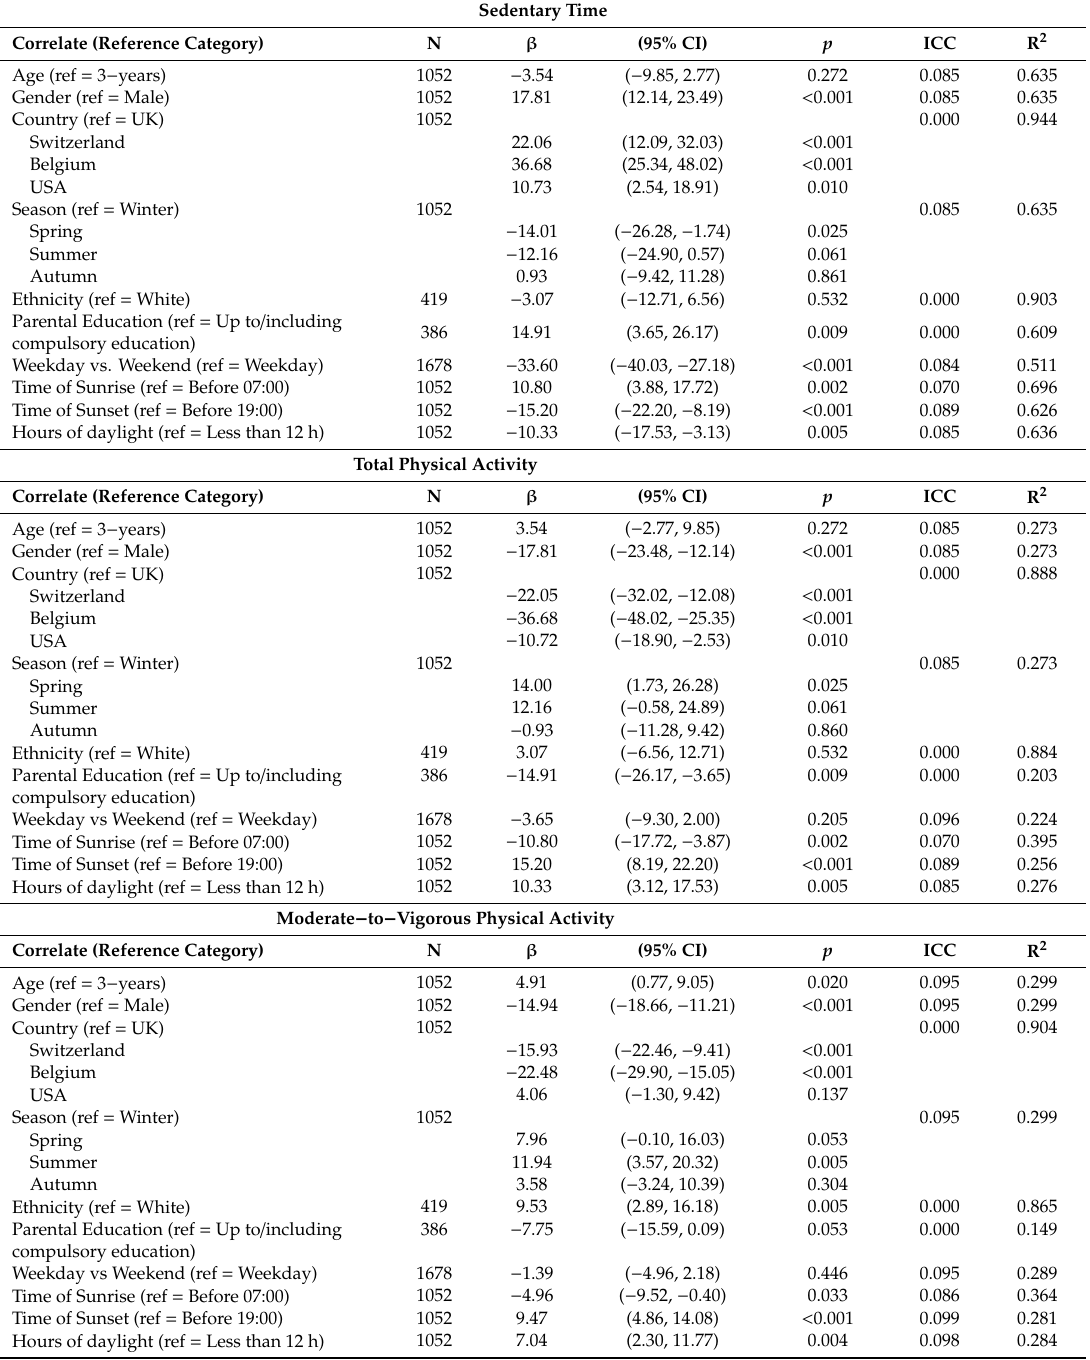
Table 3. Multi-level adjusted associations between potential correlates and average daily minutes spent in sedentary time, total physical activity, and moderate-to-vigorous physical activity in children aged